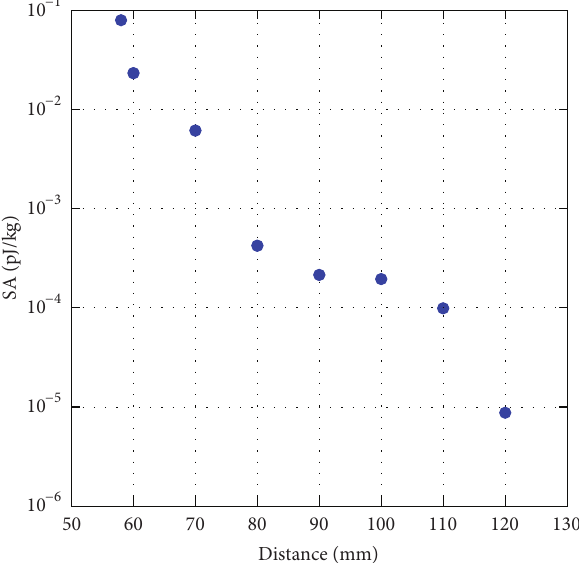
Figure 5: SA evaluated inside the various tissues of the considered multilayered body model.